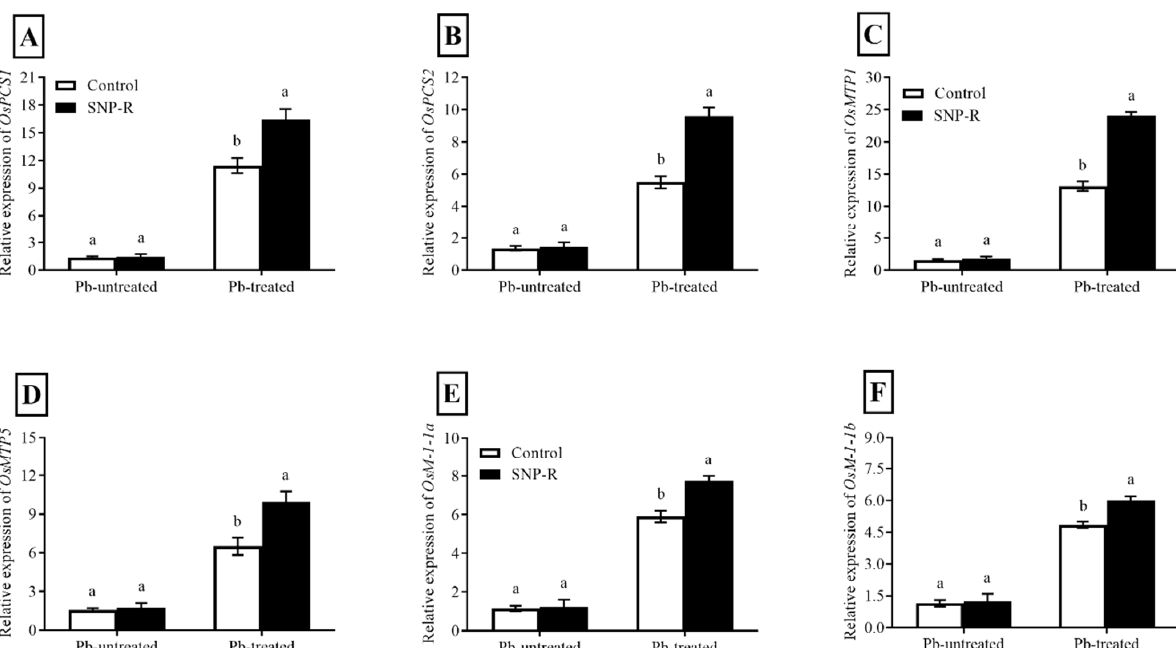
Figure 5. Effect of exogenously applied SNP on the relative expression of rice phytochelatin, metal transporter, and metallothionein protein candidate genes with or without Pb-induced stress. ( A ) OsPC1 ; ( B ) OsPC2 ; ( C ) OsMTP1 ; ( D ) OsMTP5 ; ( E ) OsM1-1a ; ( F ) OsM1-1b . Each data point indicates the mean ± standard deviation ( n = 3). Bars with different letters indicate significant differences, according to Duncan’s multiple range test. The results are compared to the respective controls (Pb-untreated and Pb-treated plants).